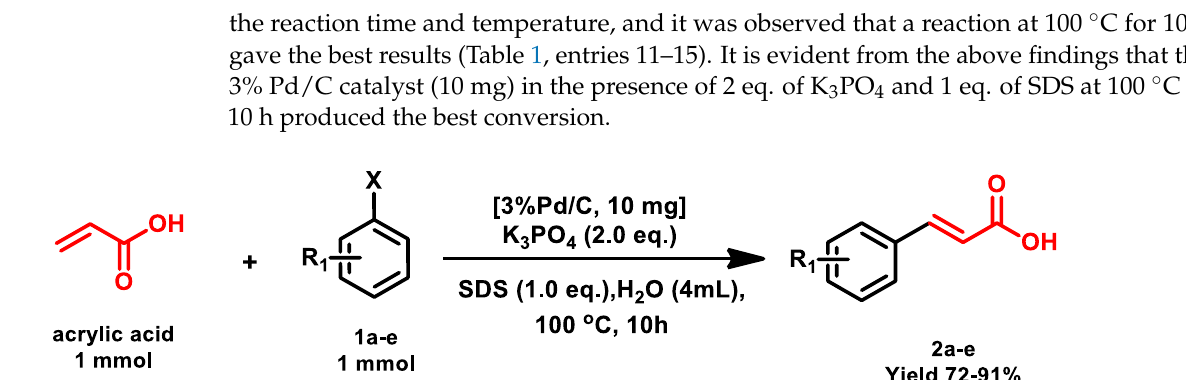
Table 2. 3%Pd/C catalyst Mizoroki–Heck reaction of aryl halides with acrylic acid.